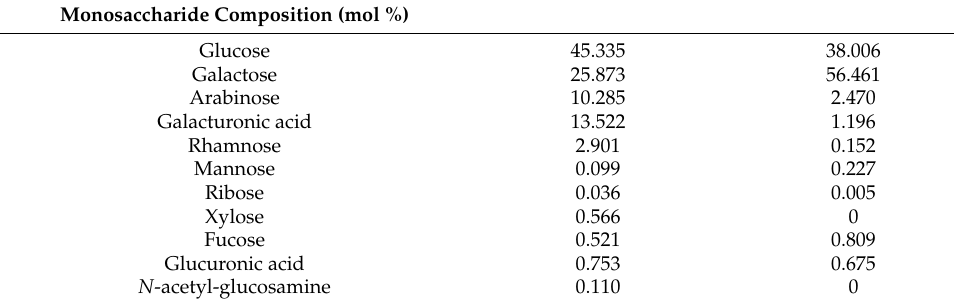
Table 2. Monosaccharide composition of different